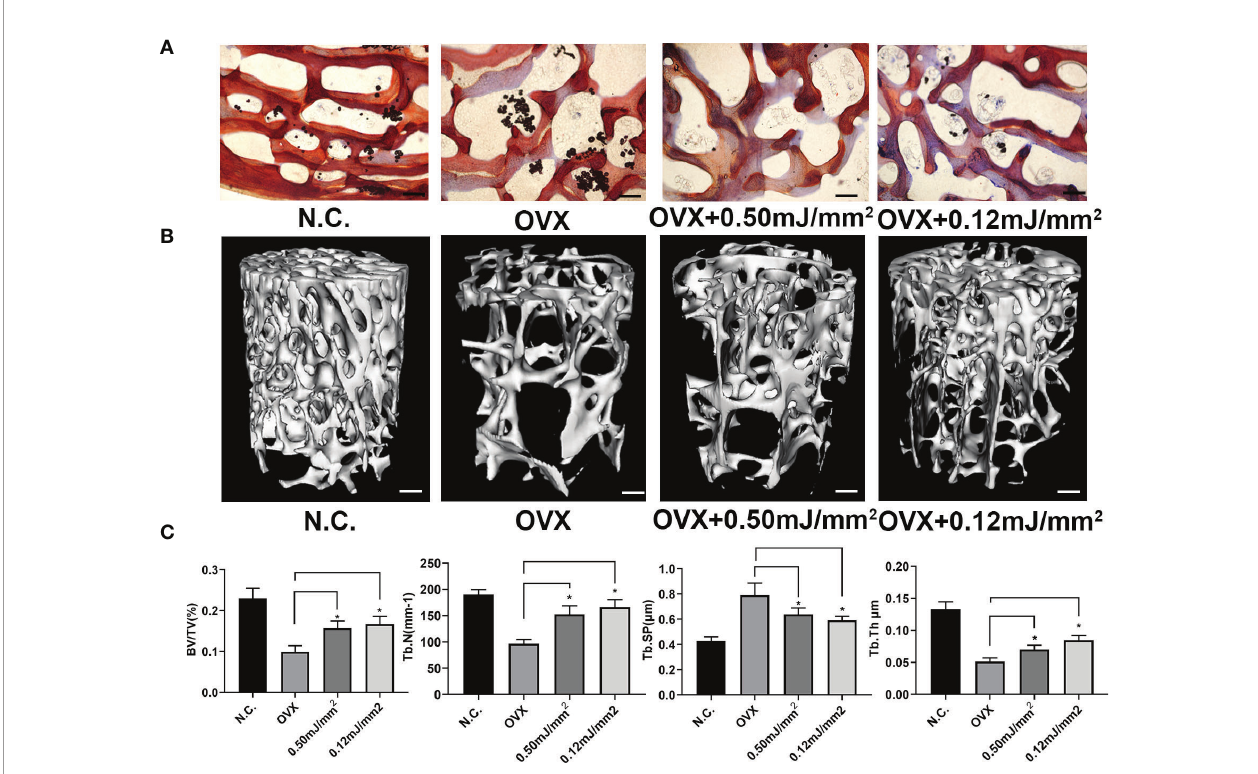
FIGURE 4 | Administration of ESW can be a potential therapy of osteoporosis. (A) Representative images of Ponceau Staining in Rabbit femurs. Scale bars =500 m m. (B) Representative micro-CT images in femur from rabbits. Scale bars =500 m m. (C) Quantitative micro-CT analysis of femur from rabbits. Data are reported as the mean ± SD. *p <